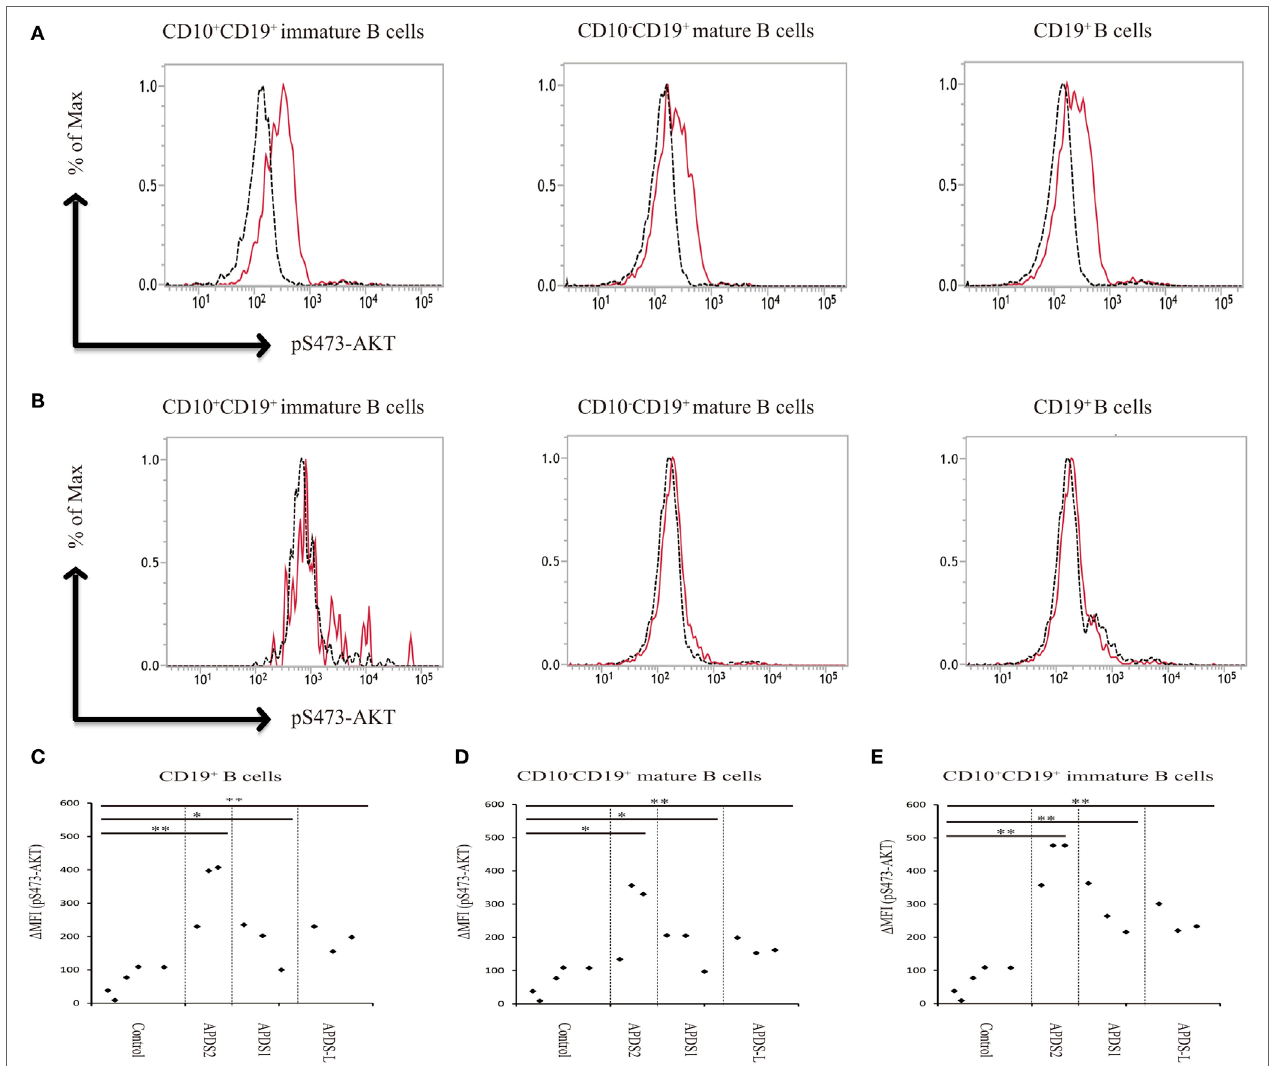
FigUre 5 | Enhanced AKT phosphorylation (pAKT) in activated PI3K δ syndrome 2 (APDS2) patients was pronounced in a flow-cytometry assay of CD10 + CD19 + B cells. (a,B) The enhancement of pAKT observed in CD19 + B cells was further investigated by separating them into CD10 + CD19 + immature B cells and CD10 − CD19 + mature B cells from P2 (representative histogram of three experiments) (a) and healthy controls (B) . The number of events analyzed was > 5,000. As an exception, CD10 + CD19 + immature B cells analyzed in healthy control were 800 events. Red solid line: no treatment and black dotted line: p110 δ inhibitor treatment. (c,D,e) A summary of difference in mean fluorescence intensity of CD19 + B cells (c) , CD10 − CD19 + mature B cells (D) , and CD10 + CD19 + immature B cells (e) from healthy controls or patients with APDS1 (three patients), APDS2 (P1, P2, and P4), or APDS-like (APDS-L) (three patients). * p < 0.05 and ** p <